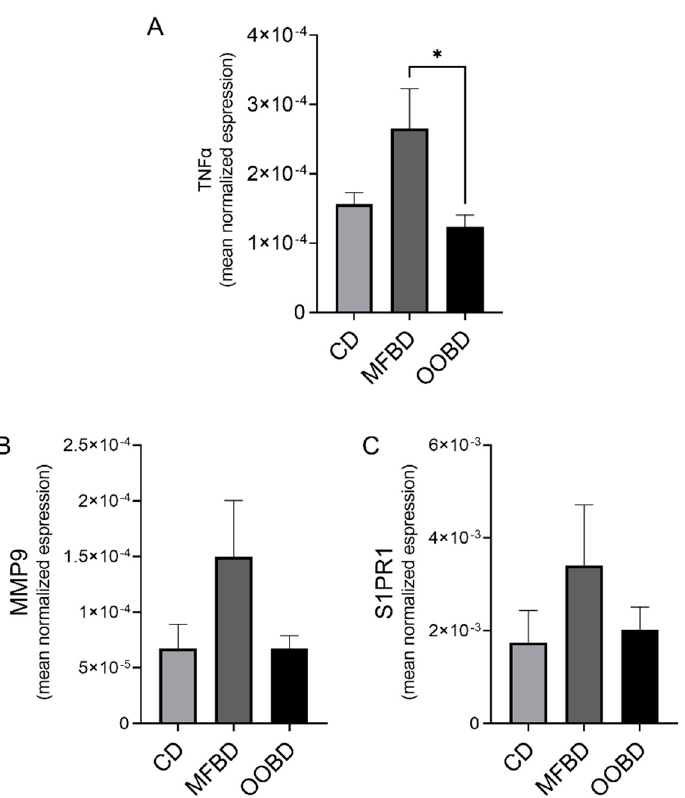
Figure 3. MFBD increases tumor necrosis factor alpha (TNF α ) expression in primary tumors in the MMTV-PyMT breast cancer model. mRNA levels of ( A ) TNF α , ( B ) matrix metalloproteinase 9 (MMP9), and ( C ) sphingosine-1-phosphate receptor 1 (S1PR1) expression in primary tumors were analyzed using real time RT-PCR and normalized to β -actin. Data represent mean ± SEM. Statistical analysis: Unpaired t -test, * p < 0.05, n ≥ 6 for each diet.